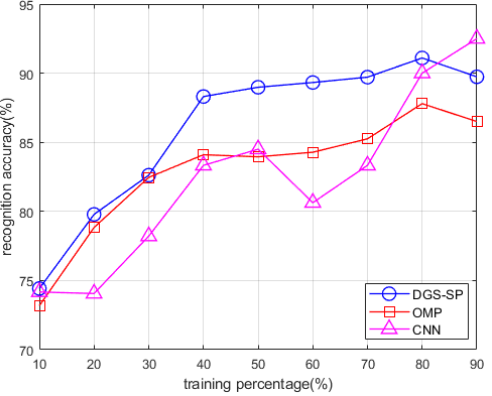
Figure 13. CNN architecture of three convolutional layers.